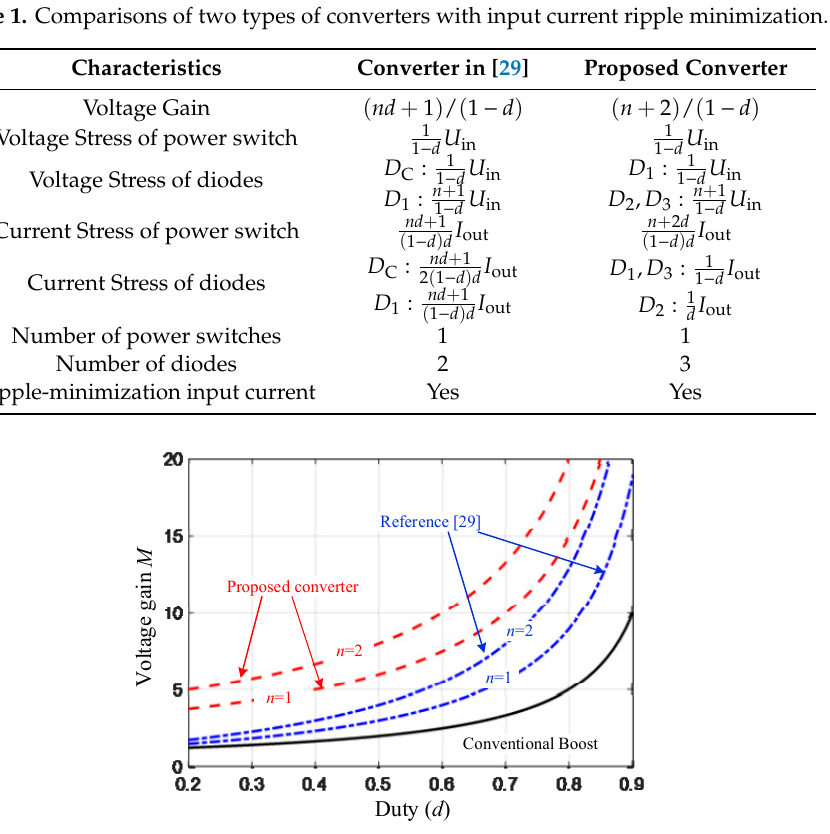
Figure 5. Curves of voltage gain versus duty cycle for two types of converters with input current ripple minimization.